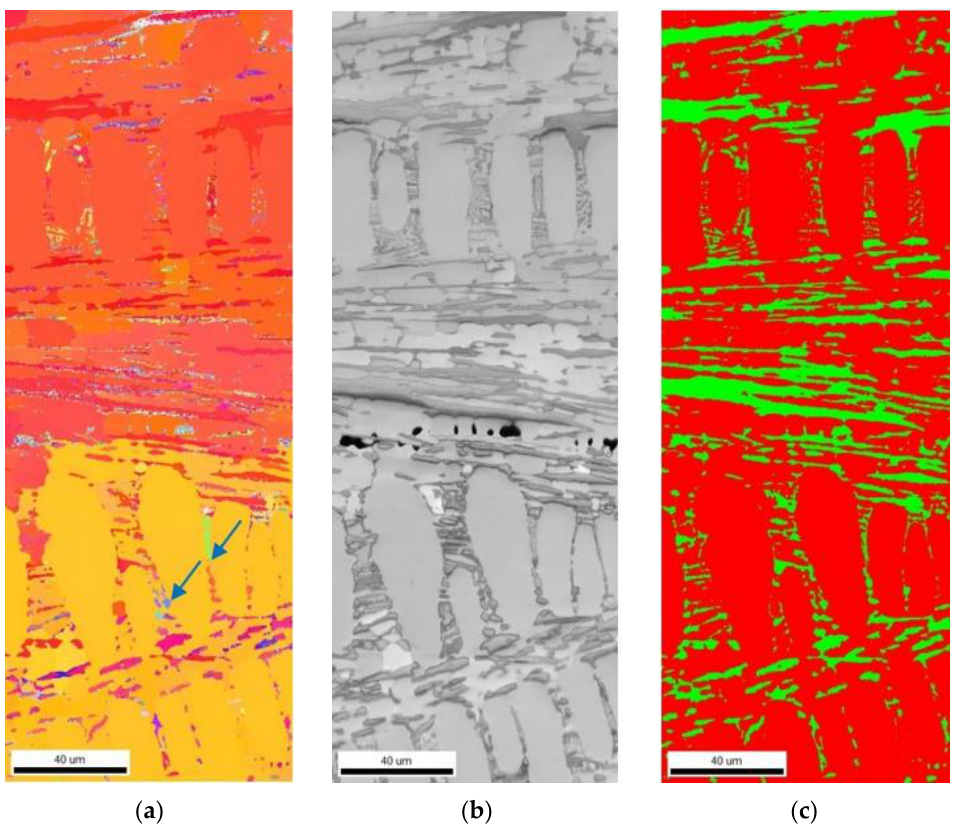
Figure 7. EBSD maps of DS specimen with dendrites showing orientation difference of M 7 C 3 carbides in the eutectic in situ composite (arrow indicates) and those in the interdendritic region. ( a ) grain map; ( b ) image quality; ( c ) phase map.